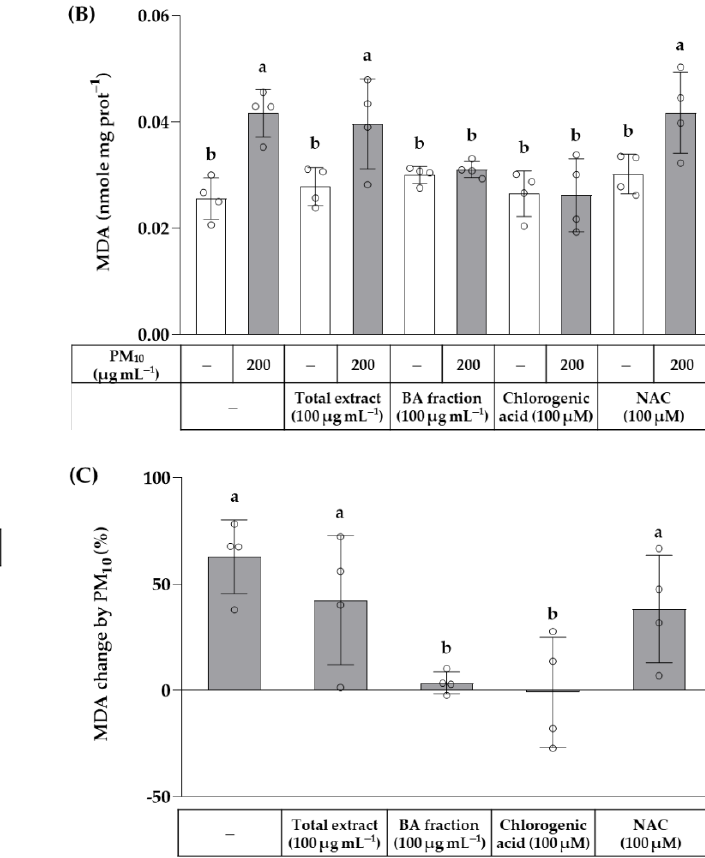
Figure 5. Effects of the total OJ extract, its BA fraction, chlorogenic acid, and NAC on lipid peroxidation in HaCaT keratinocytes exposed to PM 10 . In ( A ), cells were treated with PM 10 at different concentrations for 48 h. In ( B , C ), cells were treated with the total OJ extract (100 µ g mL − 1 ), BA fraction (100 µ g mL − 1 ), chlorogenic acid (100 µ M), or NAC (100 µ M), alone or in combination with PM 10 (200 µ g mL − 1 ), for 48 h. Lipid peroxidation was determined by measuring malondialdehyde (MDA) levels in whole-cell lysates and the values were normalized to the protein contents (nmole mg protein − 1 ) ( B ). The % change in the MDA values due to PM 10 exposure in each group was calculated using the following equation: change (%) = ( α − M)/M × 100, where α is a value in the presence of PM 10 and M is the mean value of each group in the absence of PM 10 ( C ). Data are presented as mean ± SD ( n = 4). Groups that do not share the same lowercase alphabet letters (a–c) are considered to have significantly different means at the p < 0.05